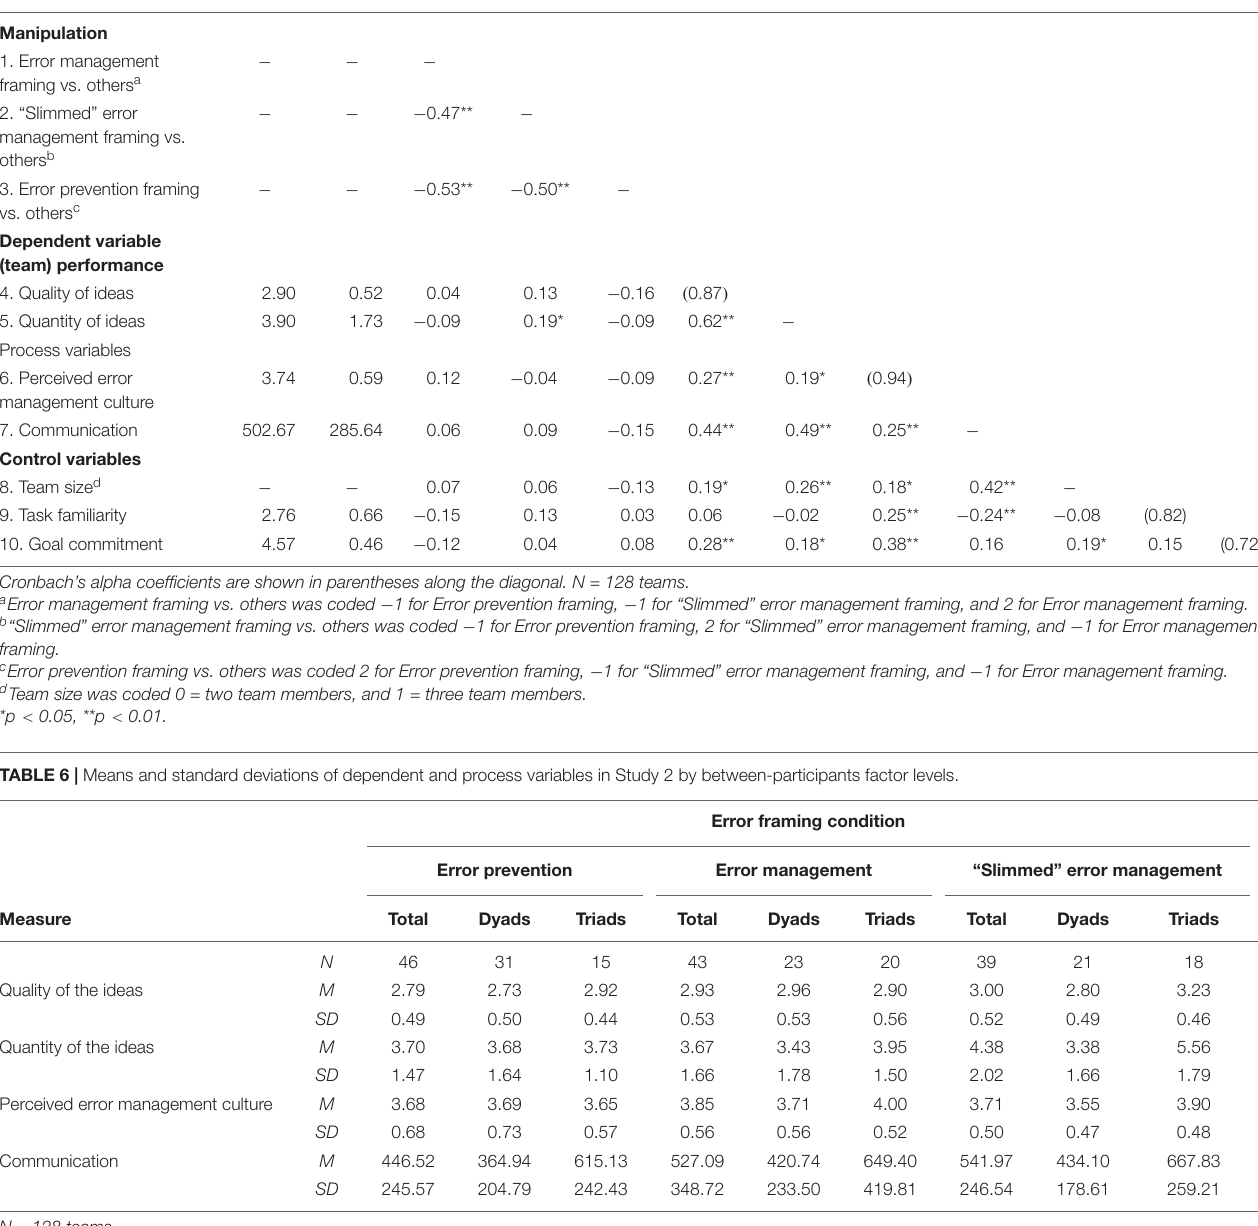
TABLE 5 | Means, standard deviations, and intercorrelations of Study 2 variables. M SD 1 2